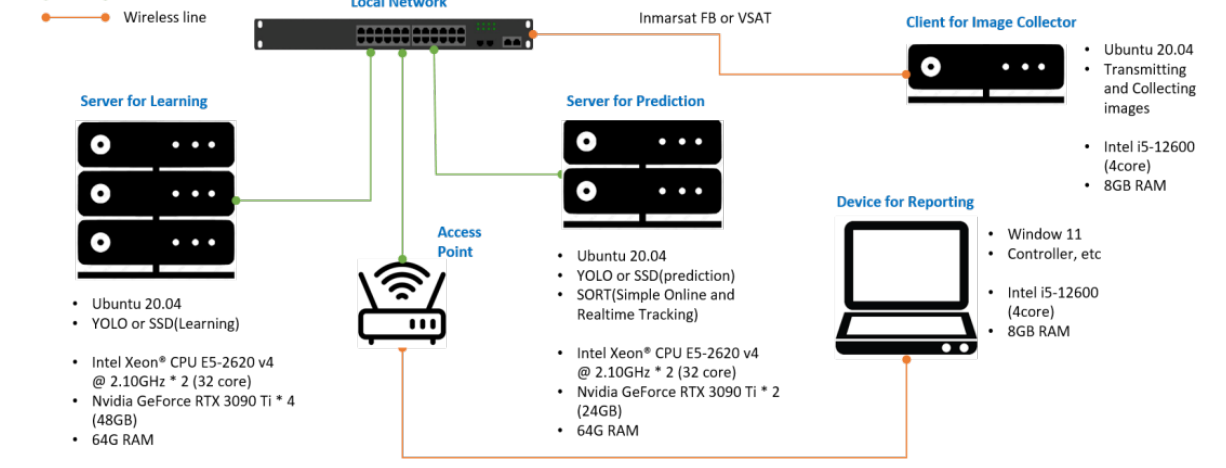
Figure 1. An overview of the proposed EM system.